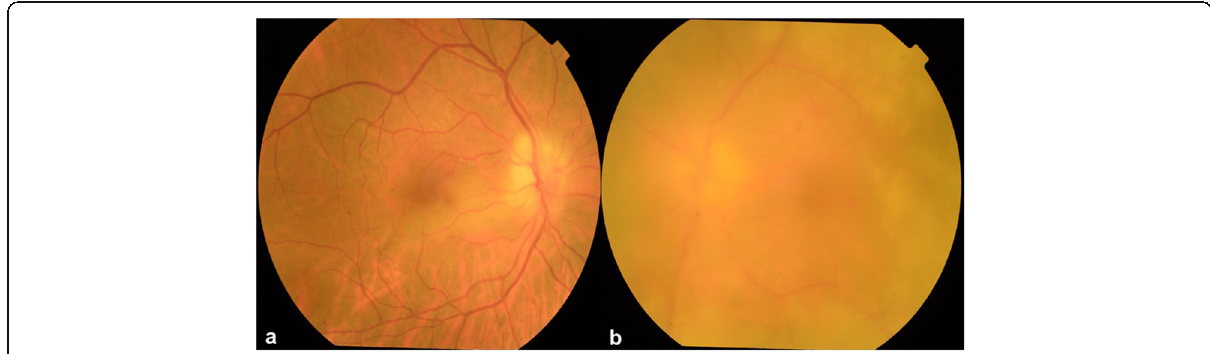
Fig. 1 a Color fundus photograph of the right eye showing an area of retinal whitening inferonasal to the fovea and edematous disc with blurred margins. b Color fundus photograph of the left eye showing hazy media due to vitritis, edematous disc with extensive tongue-shaped whitish-yellow patches of necrotizing retinitis lesions outside the arcades encroaching the posterior